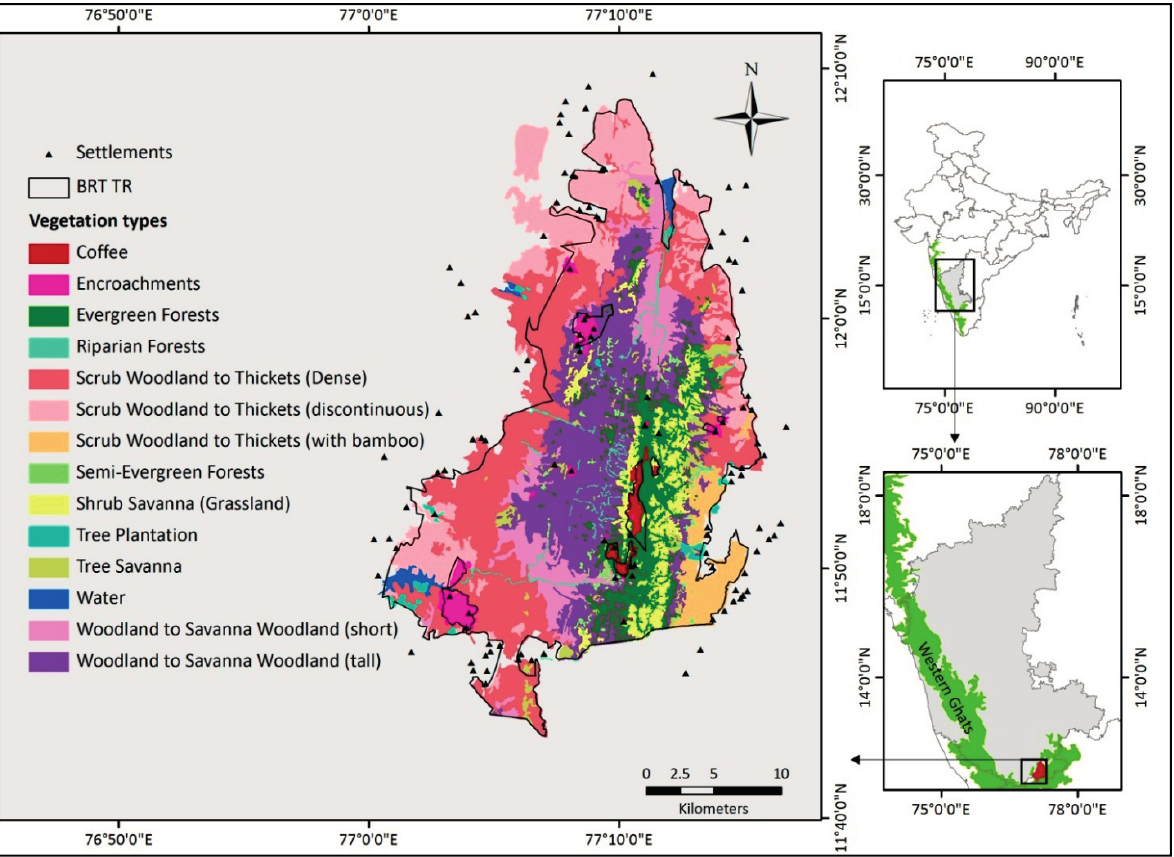
Figure 1. Map showing the location of Biligiri Rangaswamy Temple Tiger Reserve (BRT) in the Western Ghats along with various vegetation types and human